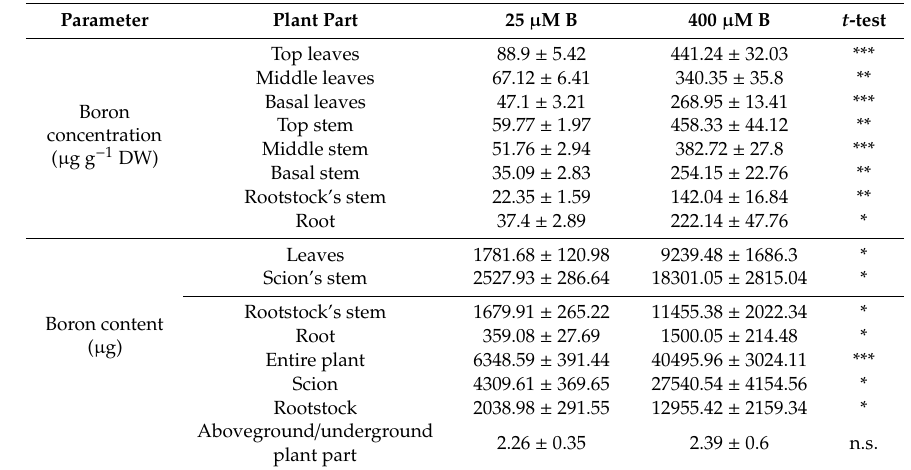
Table 2. E ff ects of B concentration in the nutrient solution (25 or 400 µ M) on the B concentration ( µ g g − 1 DW) and content (absolute quantity, µ g) in various vegetative parts of apple